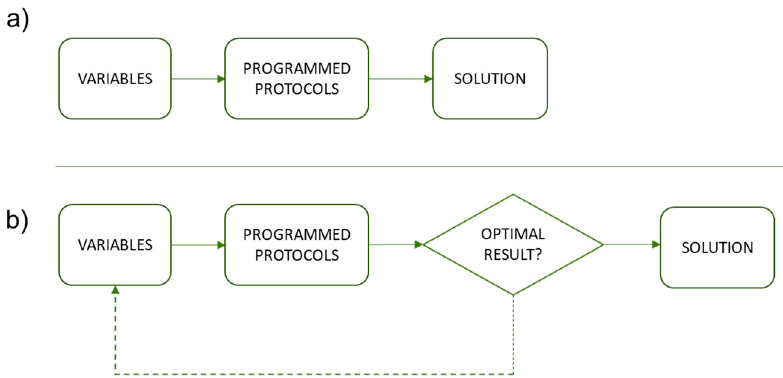
Figure 4. ( a ) Scheme of parametric model with linear sequence. ( b ) Model outline.